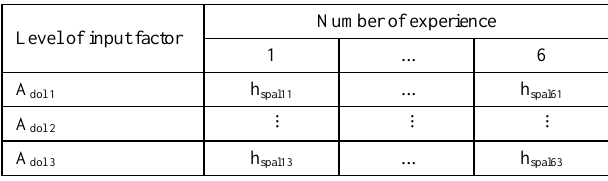
Fig. 1. Simplified physical model of the diesel engine operating process for diagnostic purposes Table 1. Matrix of the experimental research programme – complete randomized static